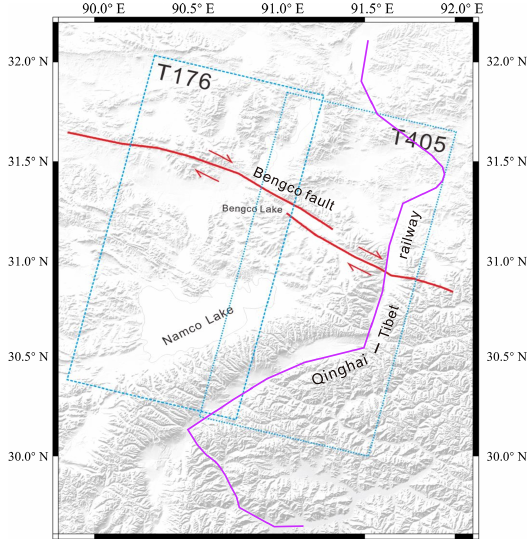
Figure 10. Bengco fault and the distribution of the SAR imagery. The blue dotted line shows the extents of the ASAR images. The red line shows the Bengco fault. The purple line shows the